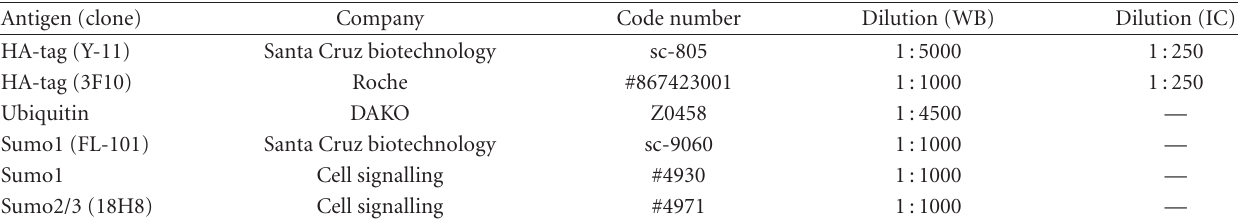
Table 2: Antibody